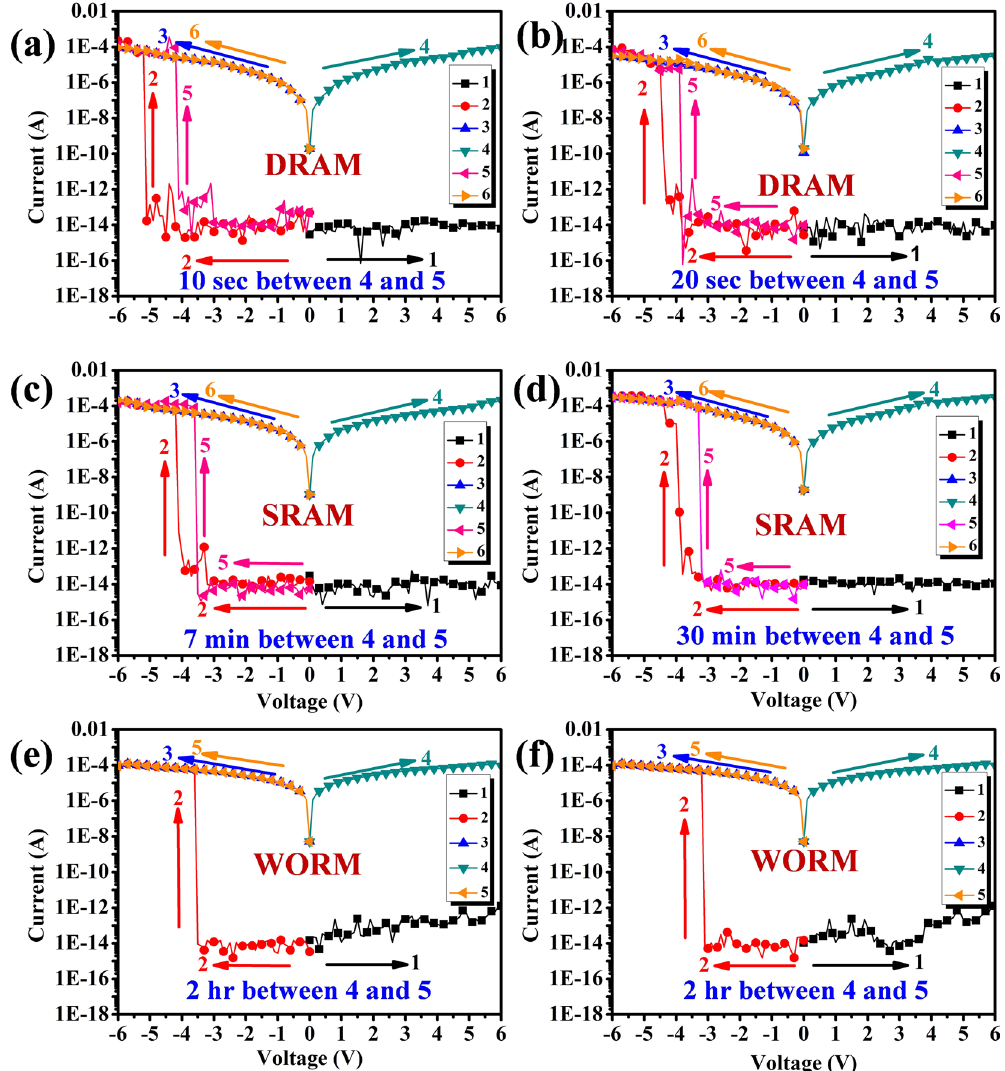
Figure 6. Current-voltage (I–V) features of the ITO/S-OH/ZrO 2 materials of hybrids (50 ± 3 nm)/Aluminum memory device. ( a ) S-OHZr5 ( b ) S-OHZr7. ( c ) S-OHZr10 ( d ) S-OHZr15. ( e ) S-OHZr30. ( f ) S-OHZr50.